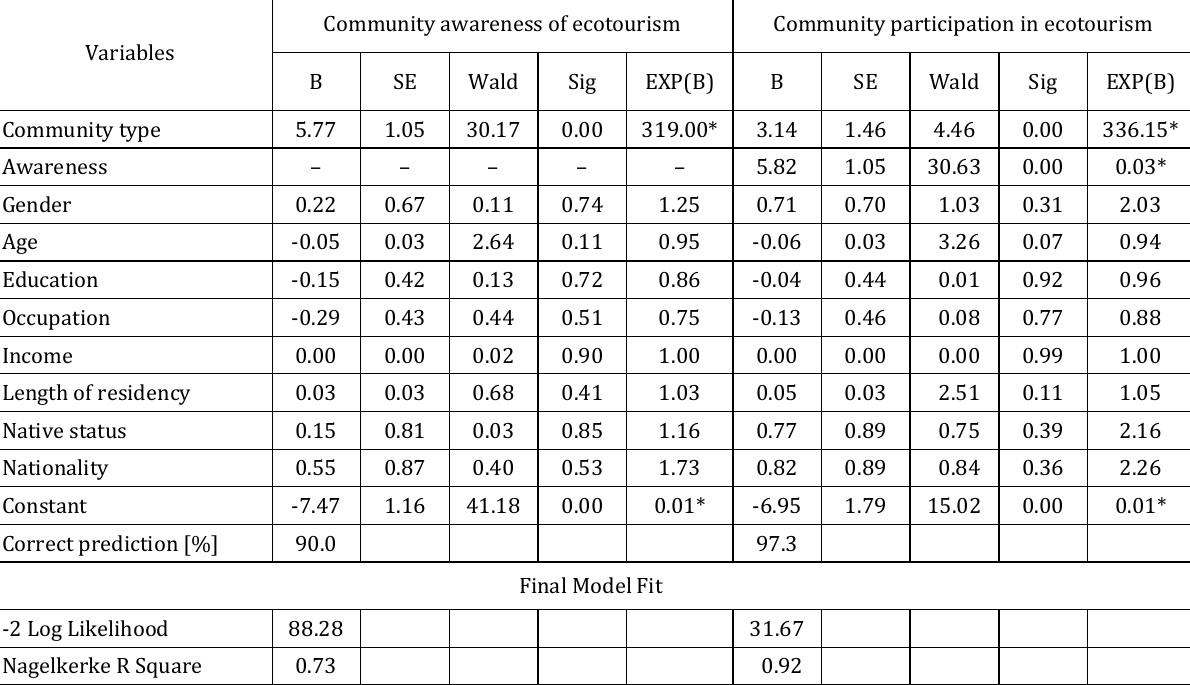
Table 7. Socio-demographic predictors of community awareness and participation in ecotourism in Old Oyo National Park Community awareness of ecotourism Community participation in Variables